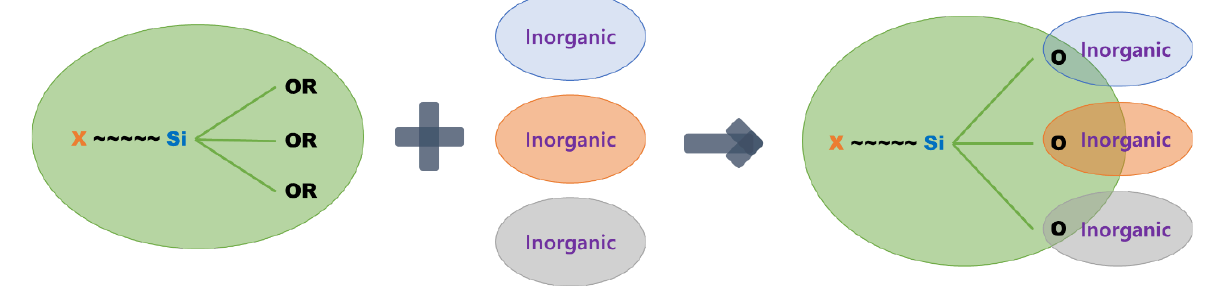
Figure 3. Silane coupling agent inorganic coupling reaction.